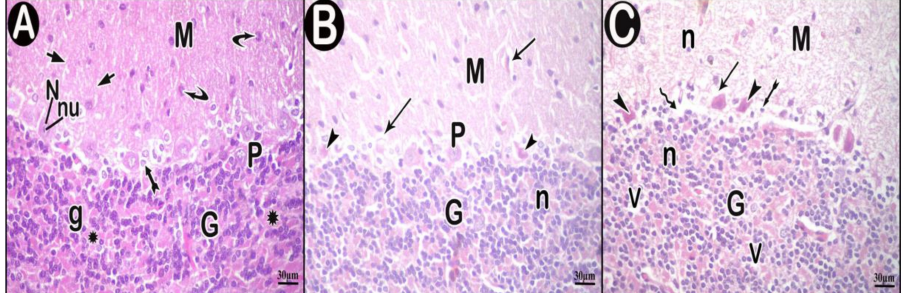
Figure 4. Hematoxylin and eosin (H&E)-stained sections in cerebellar cortex of the study groups. ( A ) control group. ( B ) low-dose group. ( C ) high-dose group. Outer molecular layer (M), fibers (short arrow), scattered cells (curved arrow), normal Purkinje cells (P), Bergmann astrocytes (tailed arrow), nuclei of Purkinje cells (N), nucleoli of Purkinje cells (nu), granular layer (G), granule cells (g), non-cellular cerebellar islands (asterisk), vacuolar spaces (arrow), atrophied shrunken Purkinje cells (arrow head), cells having darkly stained nuclei (n), areas of focal neuron loss (zigzag arrow) and vacuolations (V).